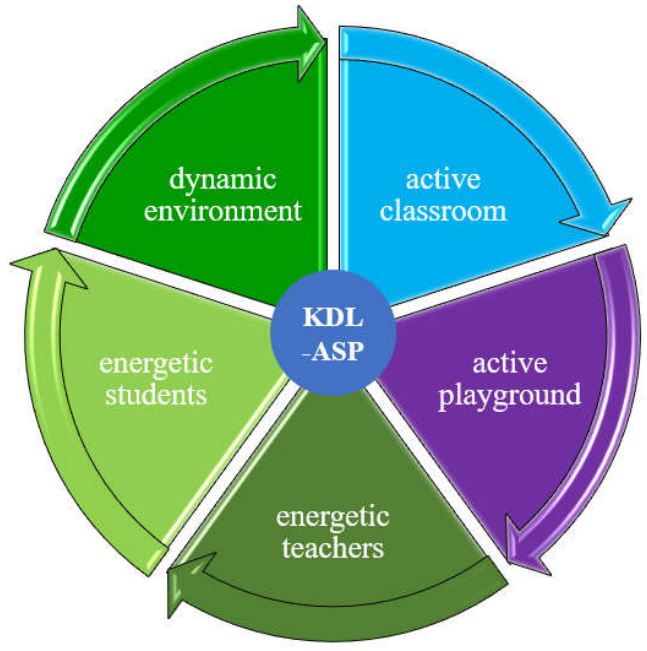
Figure 1. Elements of KDL-ASP.